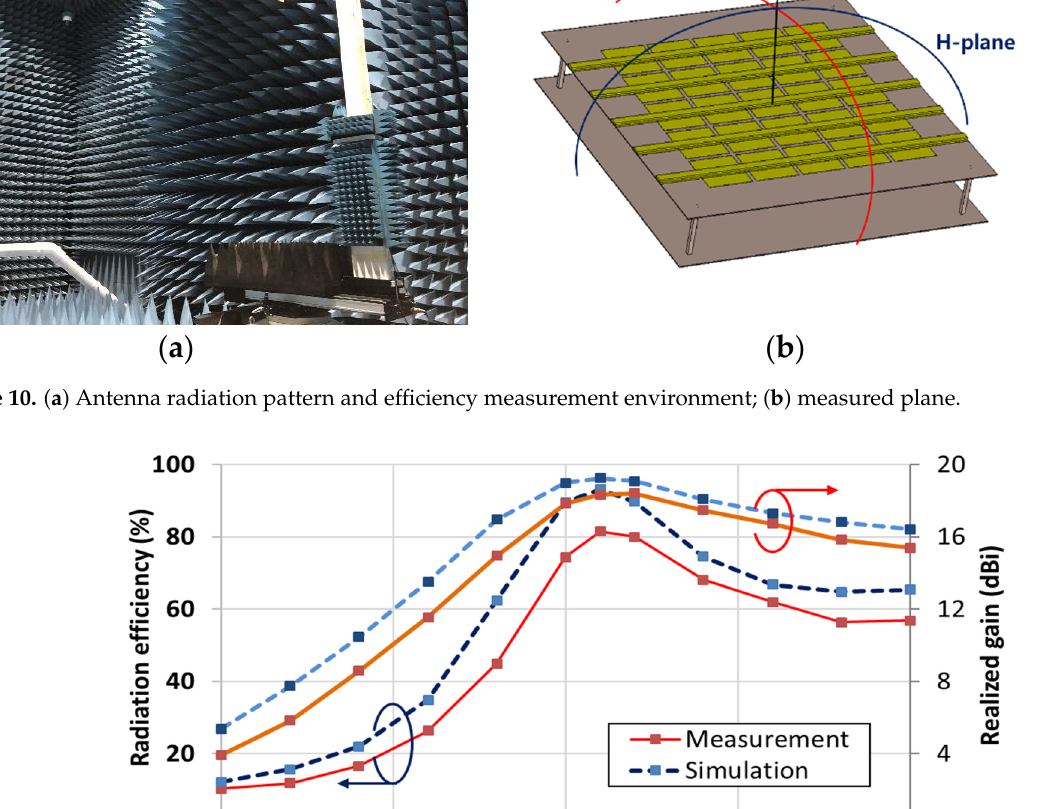
Figure 11. Antenna efficiency and gain comparisons according to frequency.